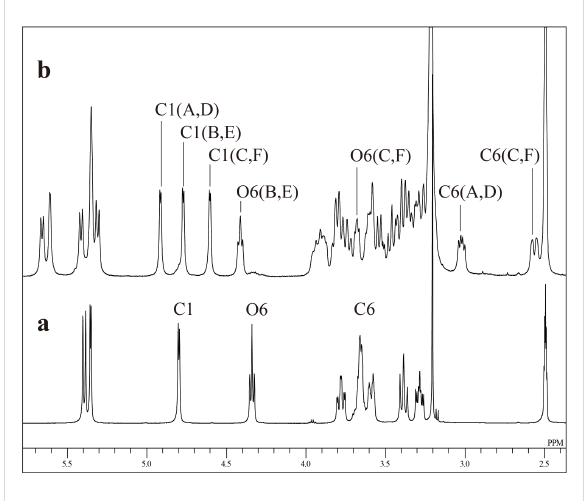
Figure 10: 1 H NMR spectra of α -CD (a) and the A,D-isomer (b) in DMSO- d 6 at 50 °C.